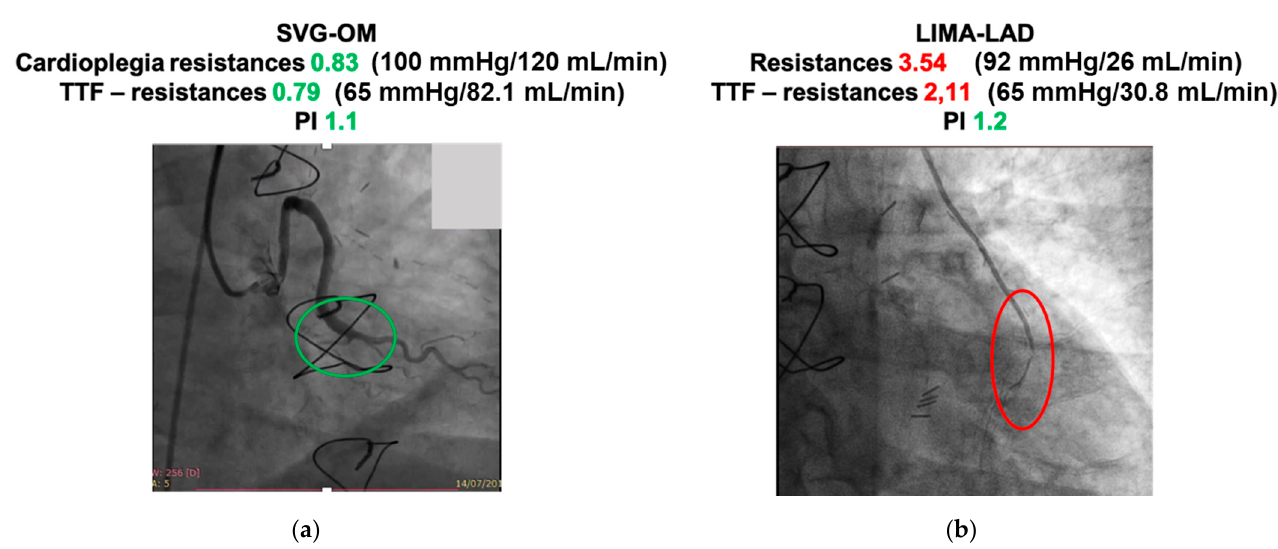
Figure 2. Examples of coronary angiographic evidence combined with intraoperative flowmetric details ( a ) patent graft with satisfactory parameters; ( b ) occluded graft with suboptimal flowmetric values. SVG-OM (saphenous vein graft to obtuse marginal); LIMA-LAD (left internal mammary artery to left anterior descending).